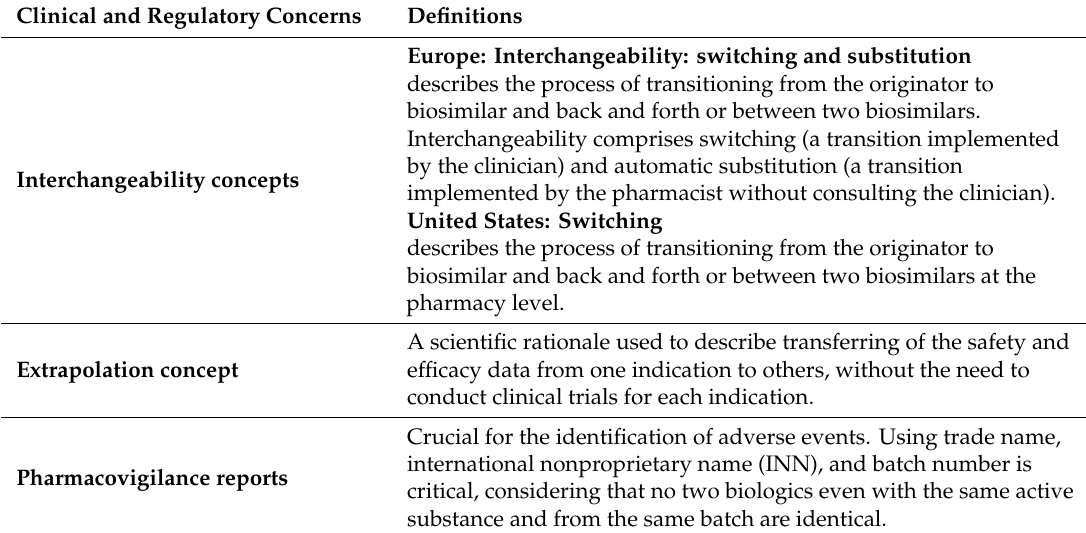
Table 3. Major clinical and regulatory concerns of healthcare professionals related to